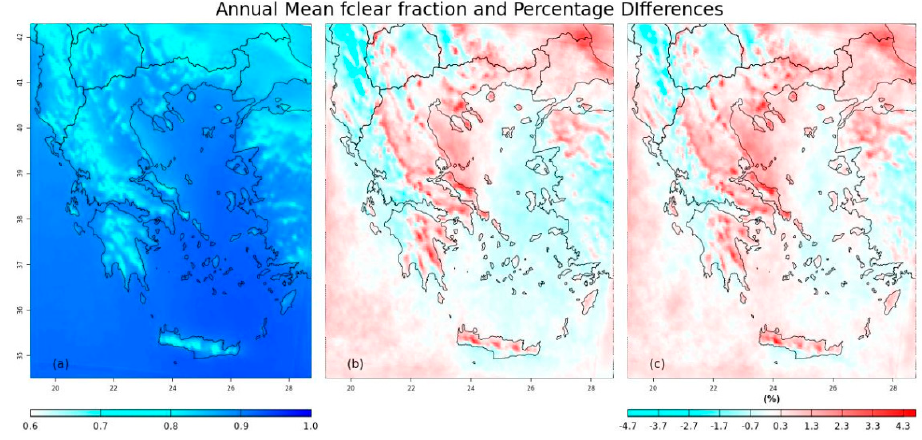
Figure 7. Mean annual f clear variable of ( a ) historical period and changes with ( b ) RCP 4.5 and ( c ) RCP